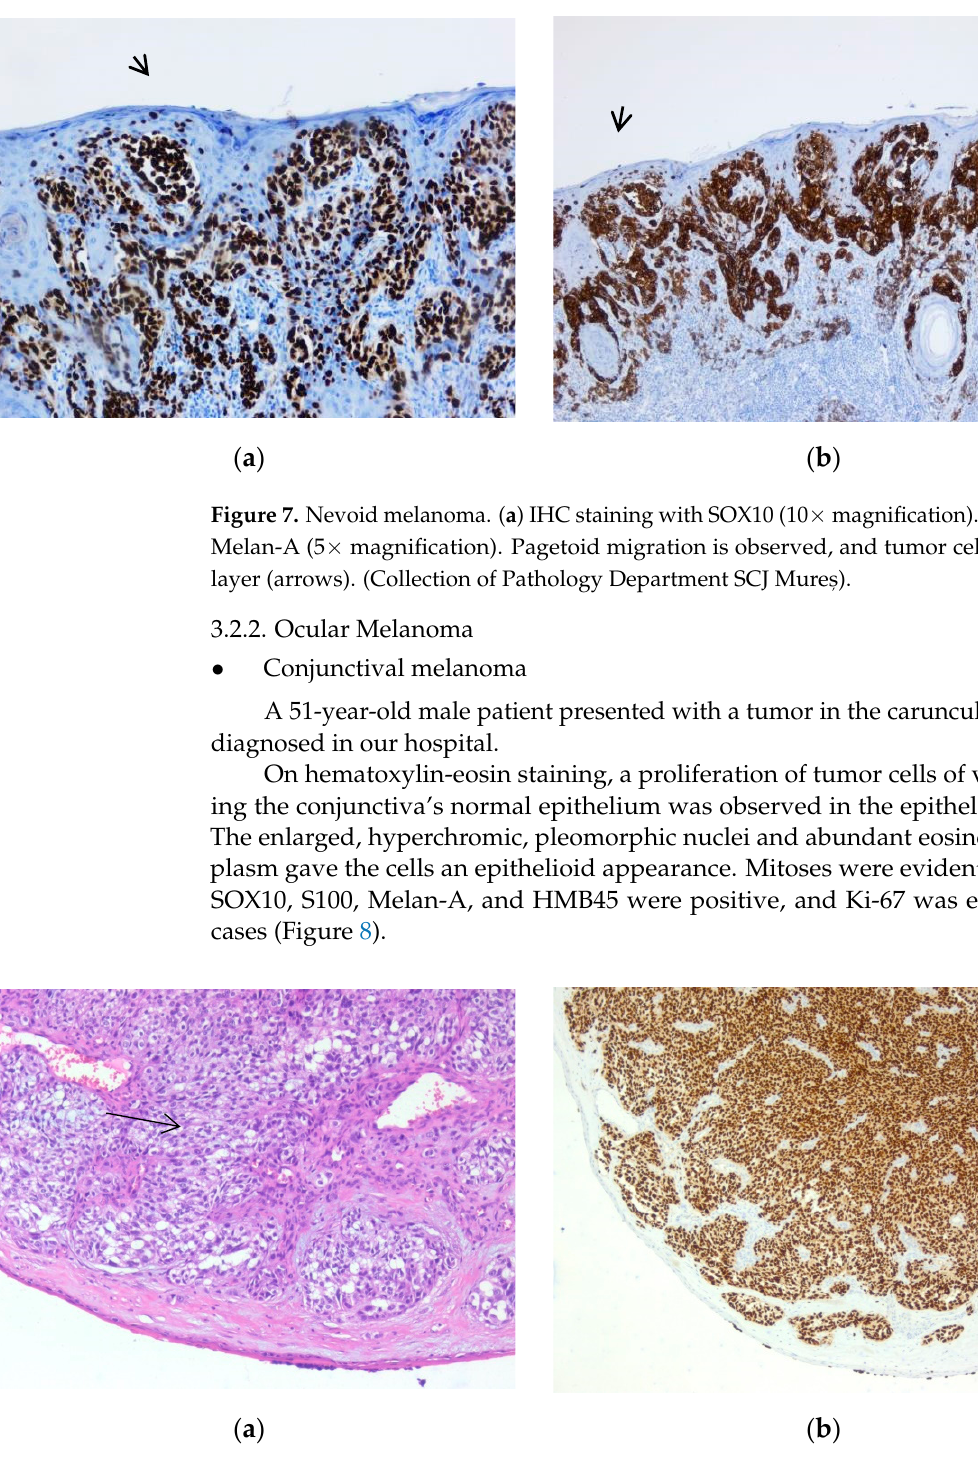
Figure 8. Conjunctival melanoma. ( a ) Tumor proliferation with nesting appearance extending in the conjunctiva (arrow). ( b ) IHC stain with nuclear marker SOX10. Both images were taken at 5× magnification. (Collection of Pathology Department SCJ Mure ș ).